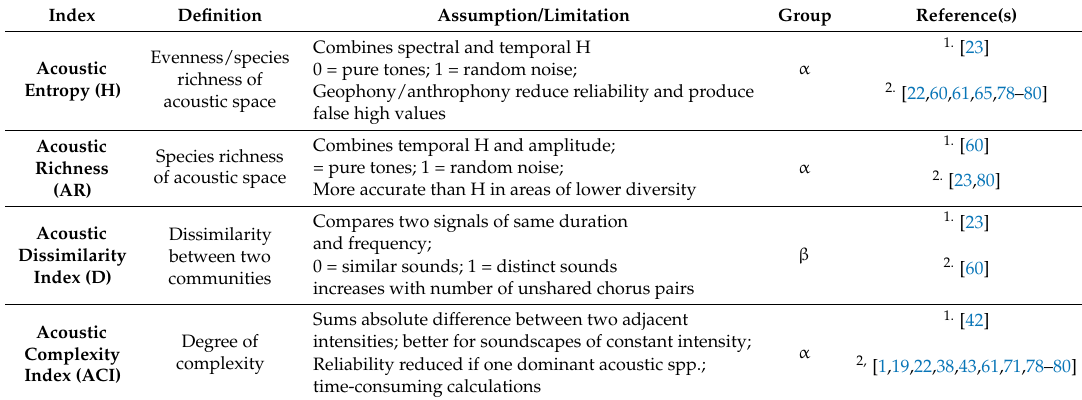
Table 3. Definitions, assumptions/limitations, and group of acoustic